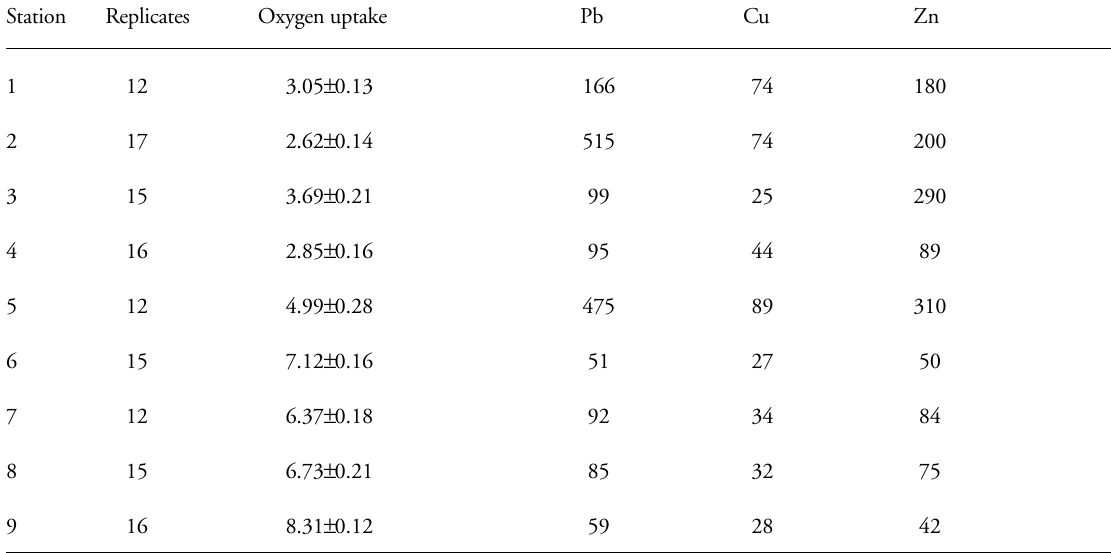
Table 2. Oxygen uptake( µ l O g -1 h -1 ) of G. balcanica specimens fed on litter contaminated by Pb, Cu and Zn. Data on 2